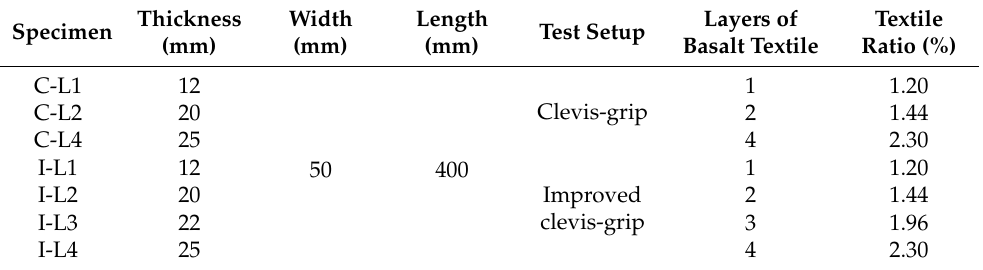
Table 2. BTRC thin plates.